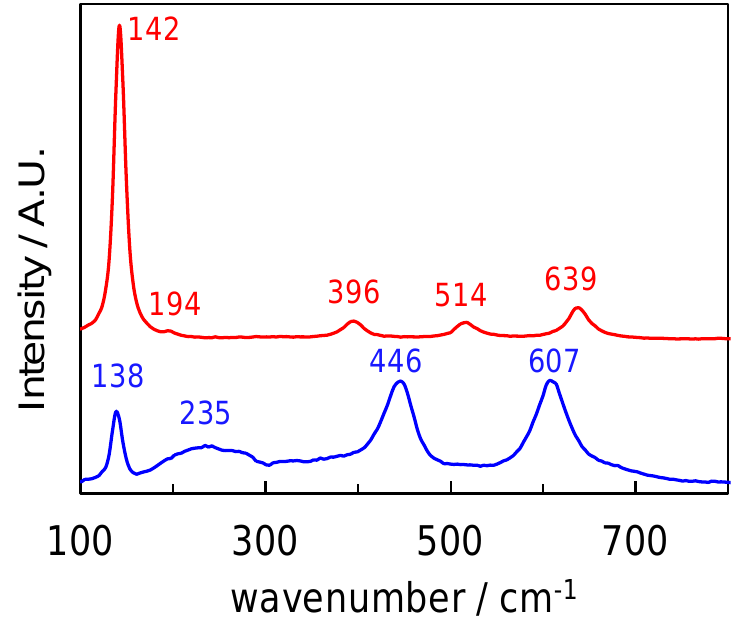
Figure 3. Raman spectra of the TiO 2 -impregnated a-silica tube (red) and the TiO 2 -coated a-silica tube by the outside vapor deposition (OVD) method